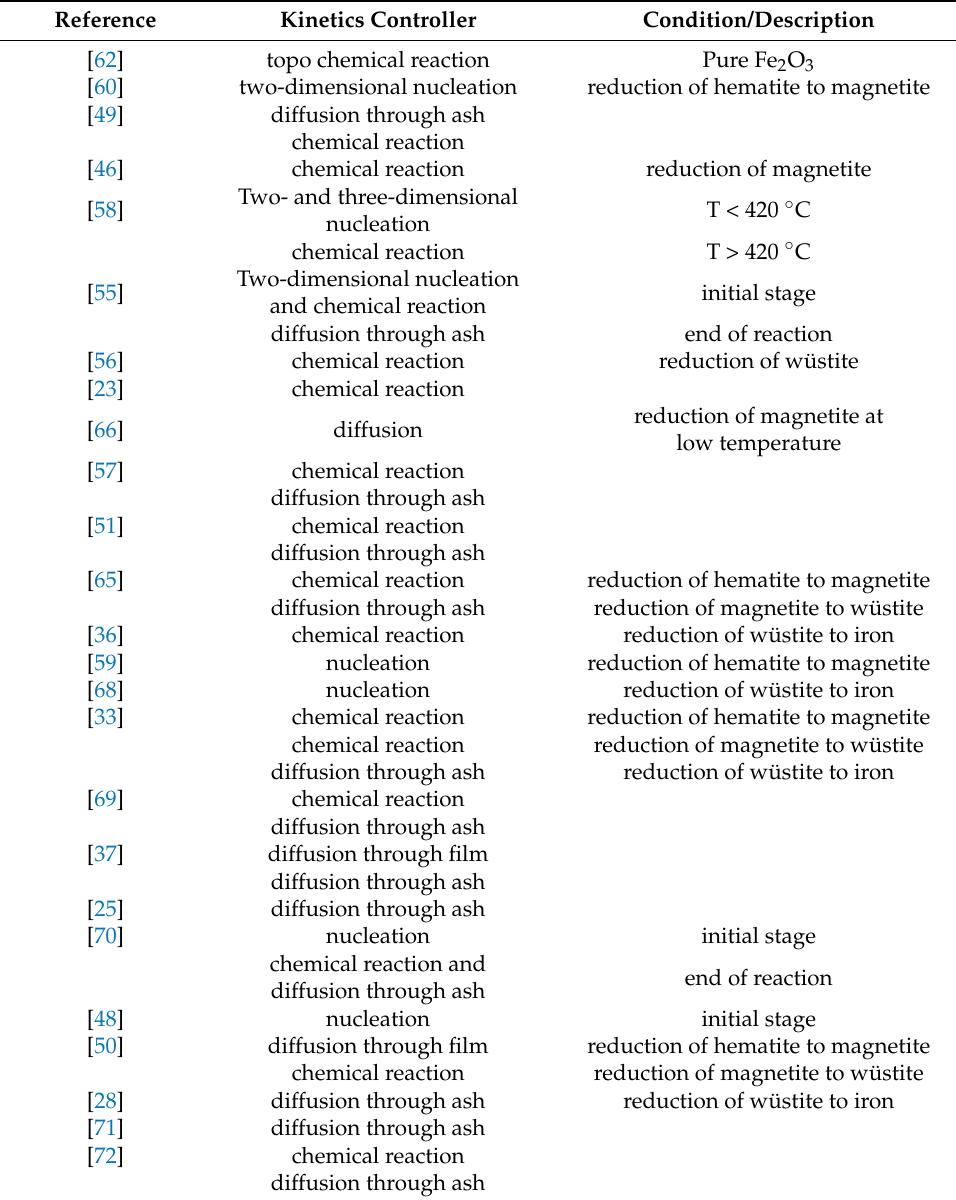
Table 2. Kinetics models of the iron oxides reduction by hydrogen due to the